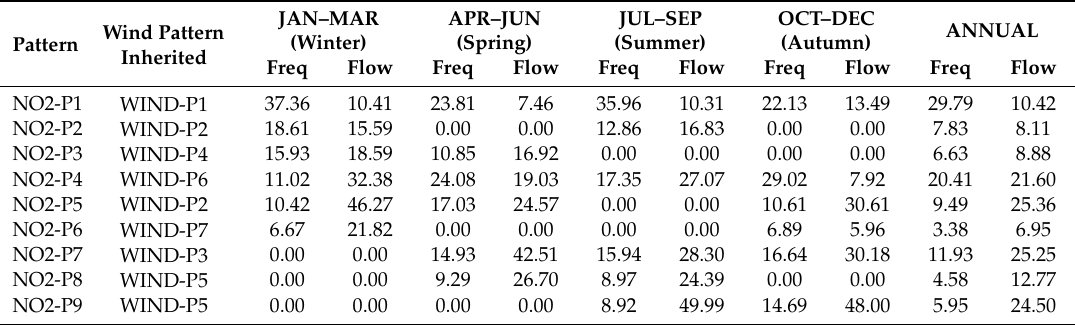
Table 4. Frequencies (%) and flow intensities ( µ g / m 2 s) of Mexico City NO 2 flow patterns (2001–2010). Wind Pattern Pattern